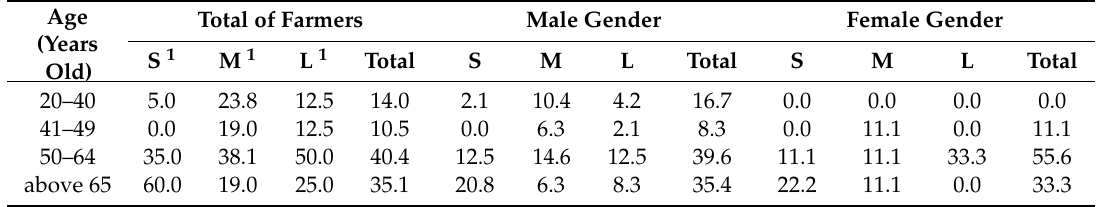
Table 2. Relative frequency (%) of age and gender of respondents by the farm size.